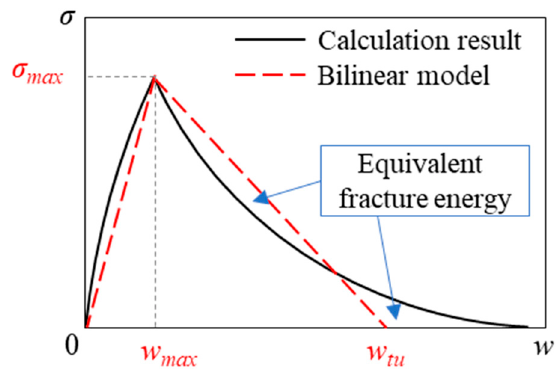
Figure 4. Bilinear model for bridging law.